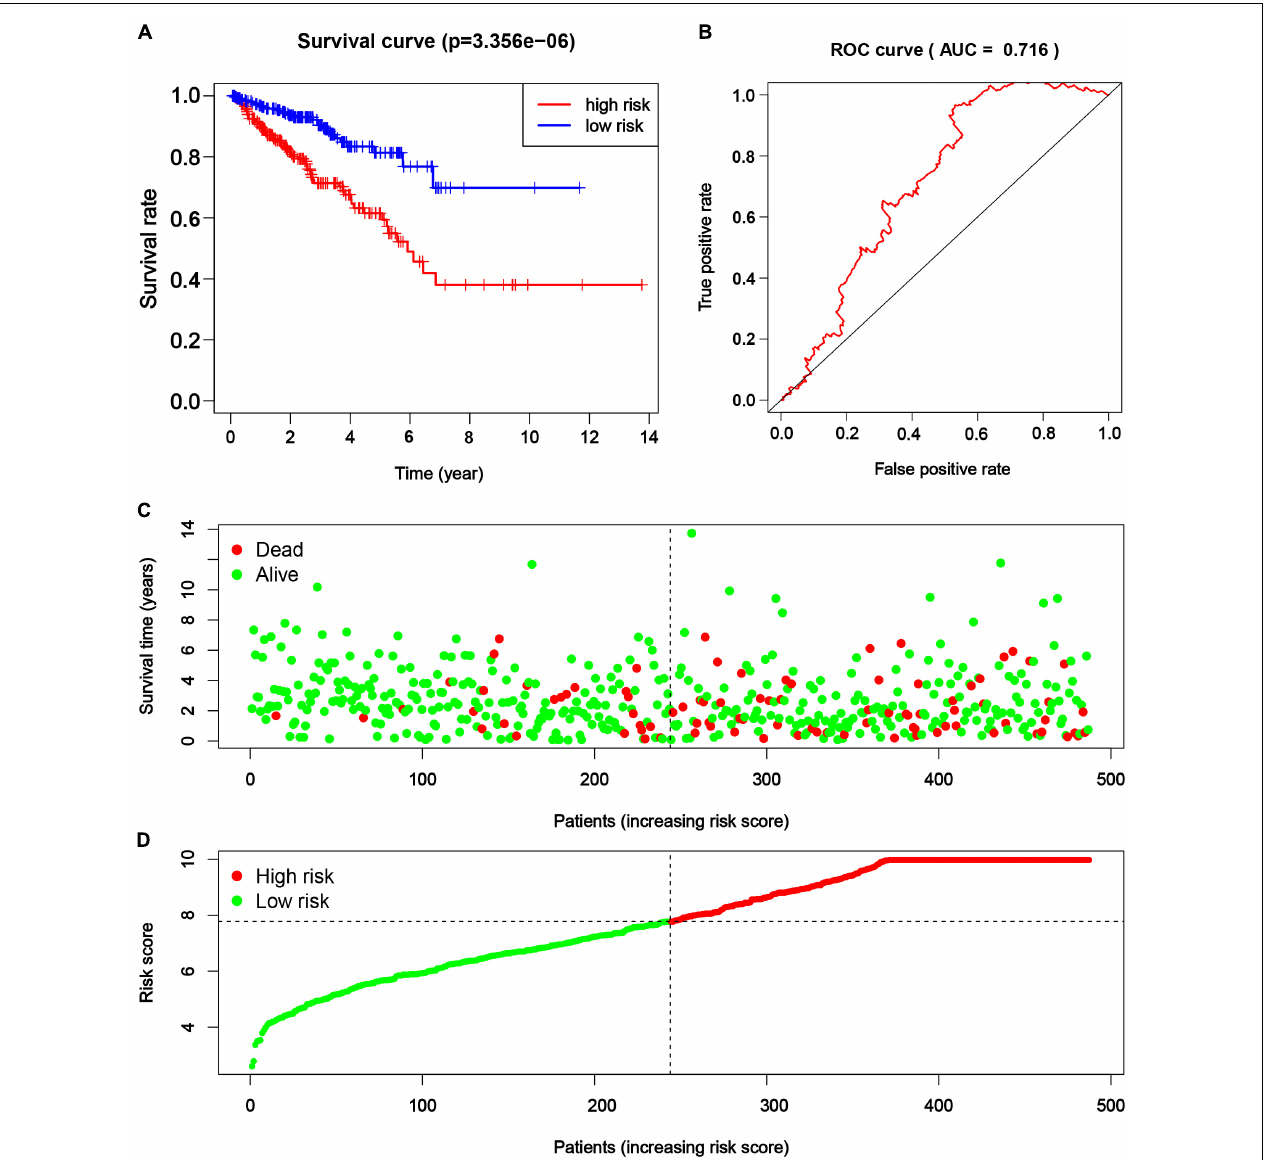
FIGURE 6 | The efficacy of novel risk signature consisted of five m 6 A regulatory genes. (A) Kaplan–Meier disease-free survival (DFS) curves for patients with higher and lower risk score ( p < 0.001). (B) Receiver operating characteristic (ROC) curve for patients with higher and lower risk score ( p < 0.001, AUC = 0.716). (C,D) Risk plots for patients with higher and lower risk